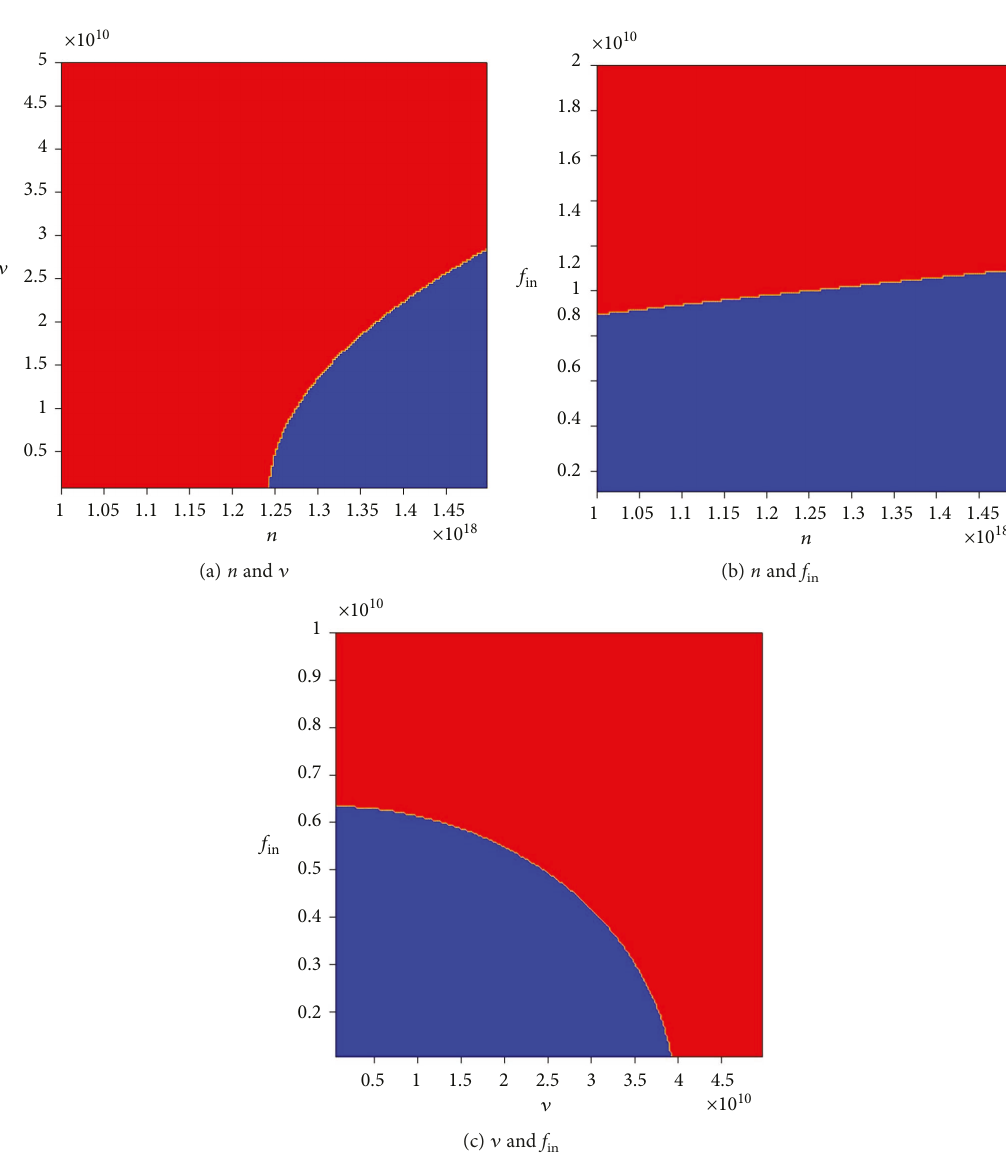
> 0 , and blue region represents ℜ ε . Red region represents ℜ ε r in